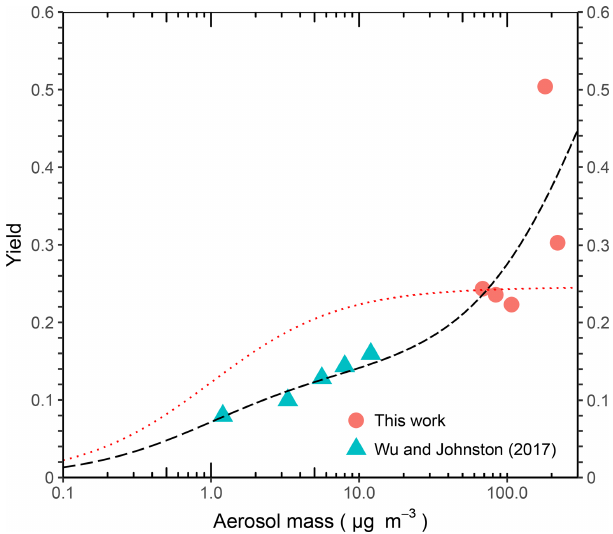
Figure 7. Two-product model fit (black long dash) and one-product model fit with a saturation concentration ( c ∗ ) of 1µgm − 3 (red short dash) overlaid with chamber data from this work and D 5 oxidation experiments of Wu and Johnston (2017). Parameters for the two- product model fit are yields of 0.14 and 0.82, respectively, for c ∗ of 0.95 and 484µgm − 3 . Parameters for the one-product model are a c ∗ of 1µgm − 3 and a yield of